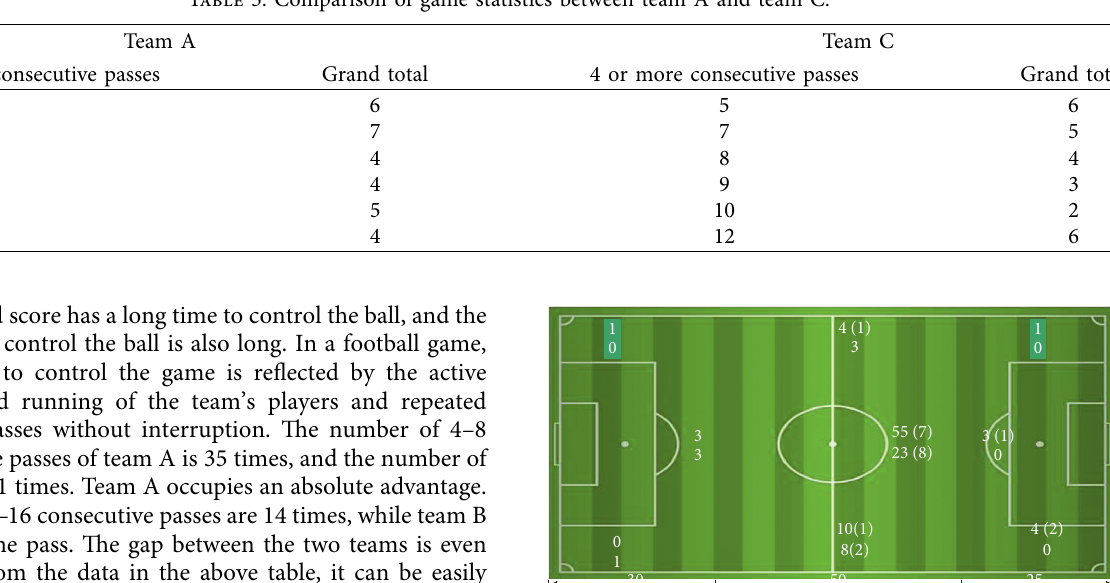
Table 5: Comparison of game statistics between team A and team C.